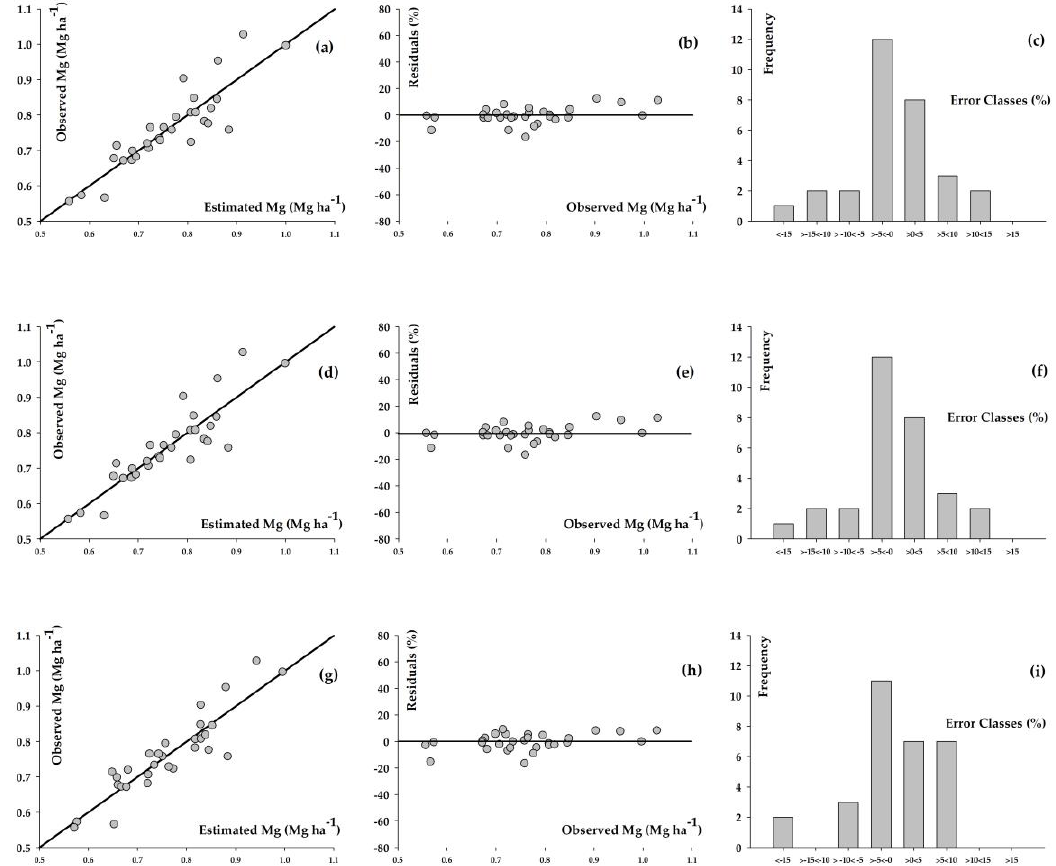
Figure 7. Dispersion of estimated value by observed value, dispersion of residues, and distribution in error classes obtained for the magnesium adjustments (Mg ha −1 ) using non-linear models, where ( a – c ) refer to the Richards model, ( d – f ) to the Weibull model, and ( g – i ) to the Schumacher–Hall model. Table 11. Validation of the Schumacher–Hall model estimating biomass and nutrients in the eucalypt stand. Variables (Mg ha −1 ) P calculated * Aggregated difference (%) Biomass 0.89 0,43 Nitrogen 0.77 −0.57 Phosphorus 0.14 −4.09 Potassium 0.08 −3.28 Calcium 0.09 −3.78 Magnesium 0.70 −3.47 * Calculated by the t -test for two samples assuming equivalent variances.